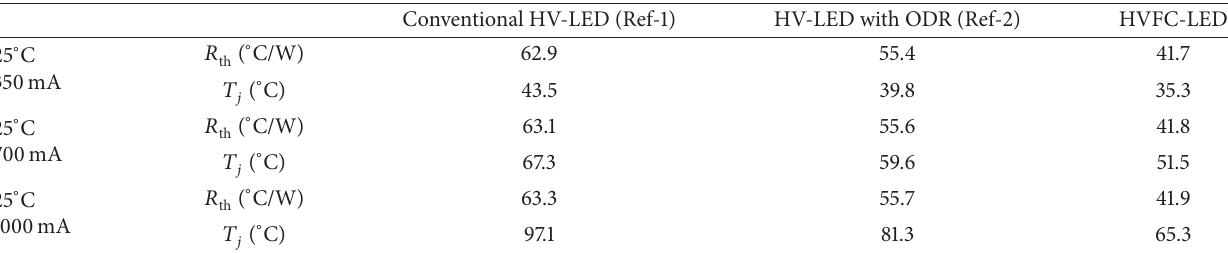
Table 1: The R and 𝑇 𝑗 comparison of three kinds of LED. th Conventional HV-LED (Ref-1) HV-LED with ODR